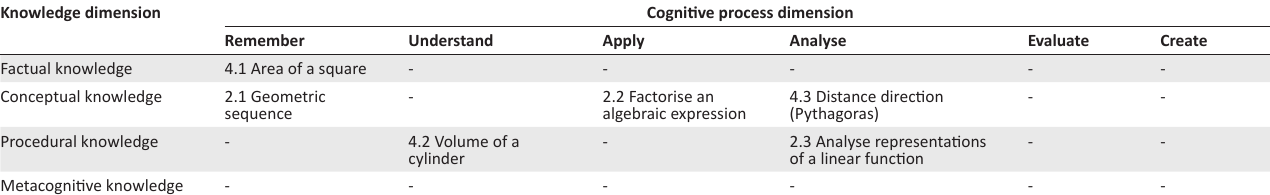
TABLE 1: Revised Bloom’s taxonomy manifesting two dimensions used to classify assessment items in the mathematics monitoring and evaluation project. Knowledge